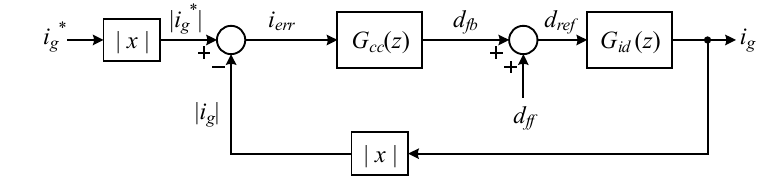
Figure 6. Current controller structure.